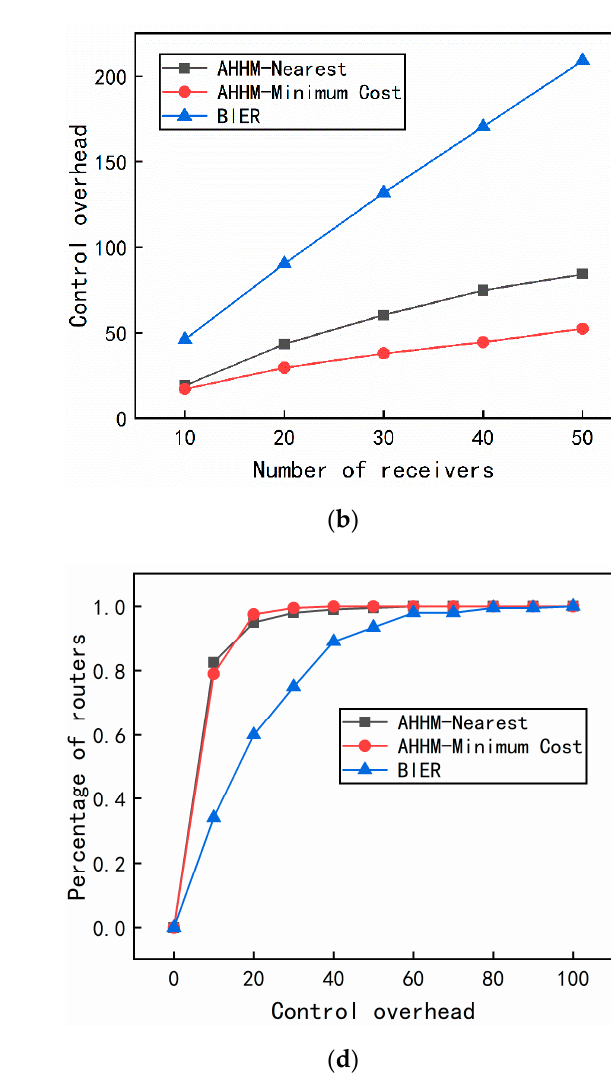
Figure 8. The comparison of the control overhead. ( a ) The comparison of the control overhead with different thresholds; ( b ) The comparison of the control overhead with different numbers of receivers; ( c ) The comparison of the control overhead with different numbers of groups; ( d ) The CDF of the control overhead in each multicast method.